Question: Identify the chart type used in this figure.
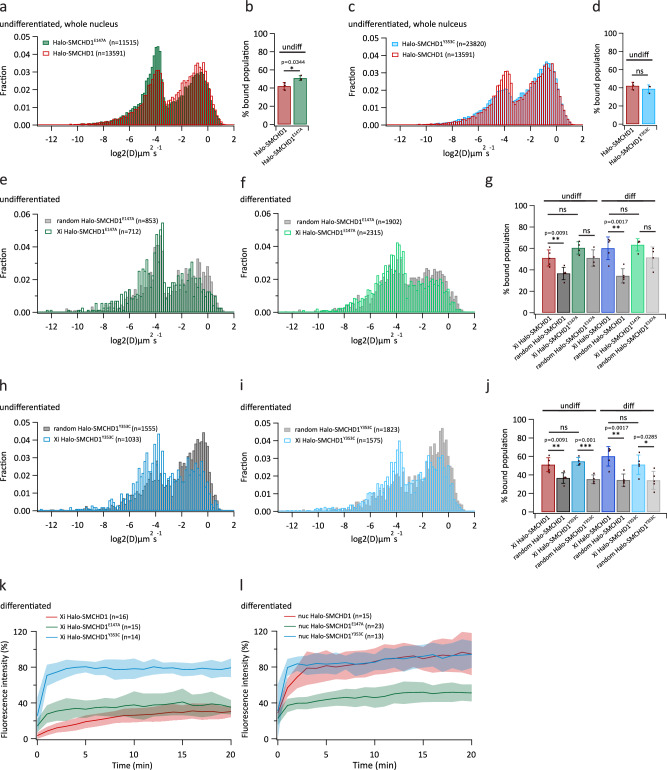
Answer: histogram